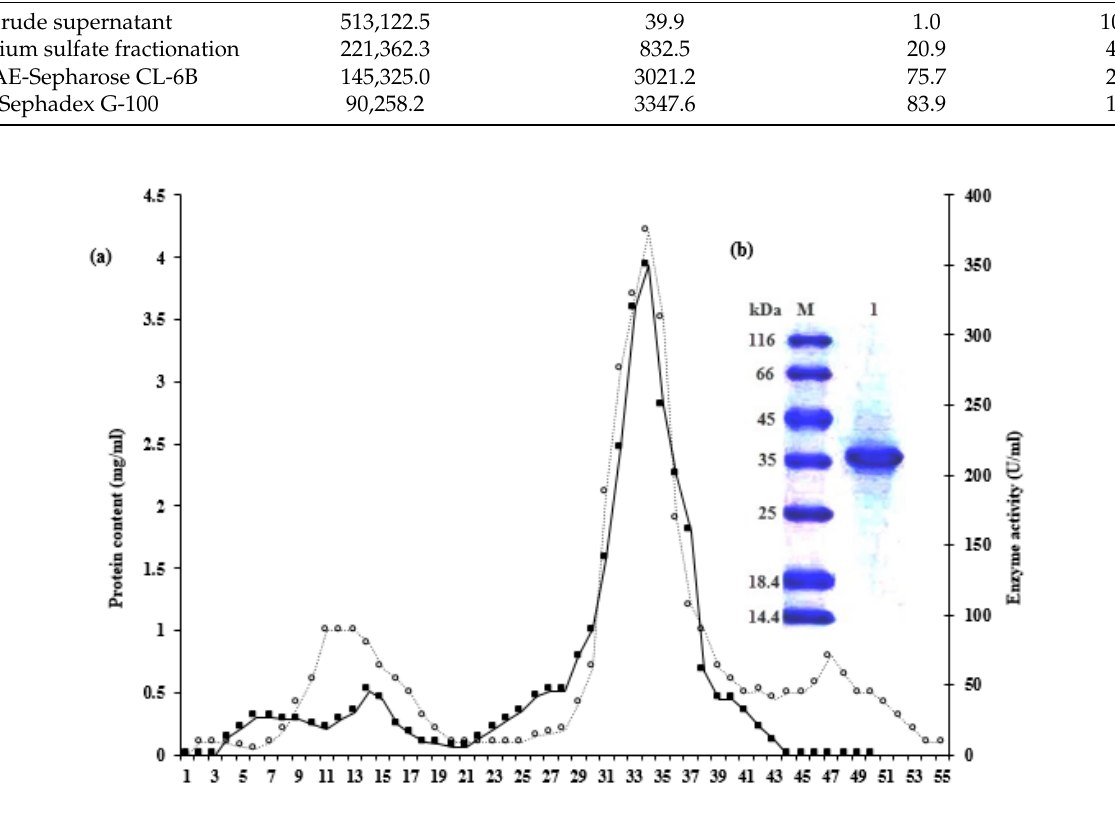
Figure 1. Elution pattern of protease through Sephadex G-100 (panel ( a )) and SDS-PAGE (panel ( b )). Lane M was loaded with the marker proteins, while lane 1 was loaded with the purified protease. Table 1. A brief of protease purification steps.